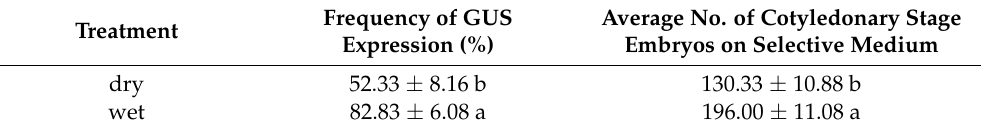
Table 4. Effects of FECs with dry or wet treatment on cassava SC8